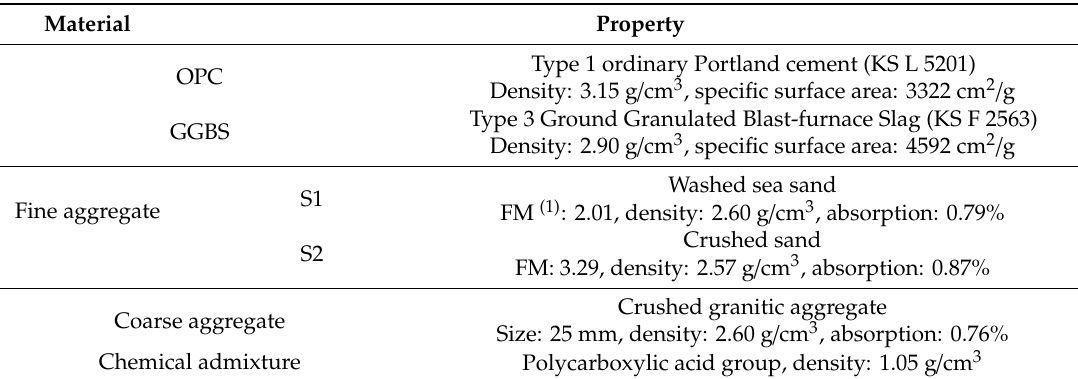
Table 2. Physical properties of the